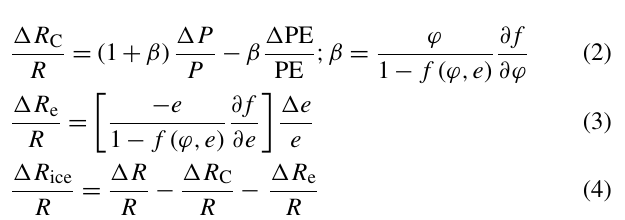
Figure 2. Décomposition de la courbe de Budyko. CC : Change- ment climatique; AE : Evapotranspiration réelle; PE : Evapotrans- piration potentielle; P : Précipitation.